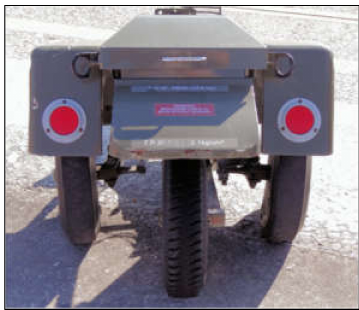
Figure3. AMu-meterwithitstwo friction measuringtiresat bothsidesofafree-rollingspeed-measuring tire. The photo was shot in another project.